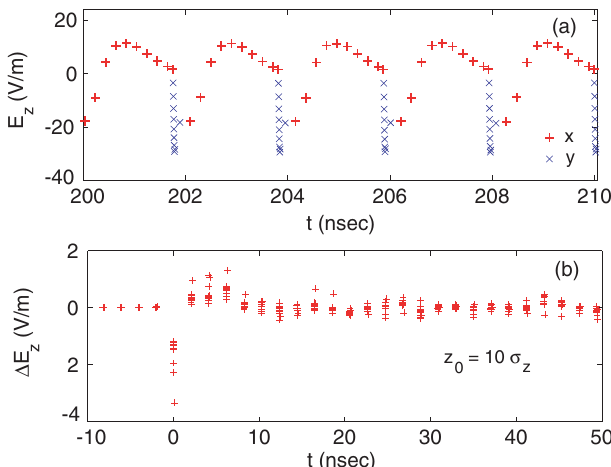
FIG. 22. (Color) Longitudinal electric field (a) and wake force (b) for super KEKB (2 ns spacing). A bunch experiences an electric field plotted by blue markers ( (cid:8) ) in plot (a). The red in the interbunch markers (+) represent E z